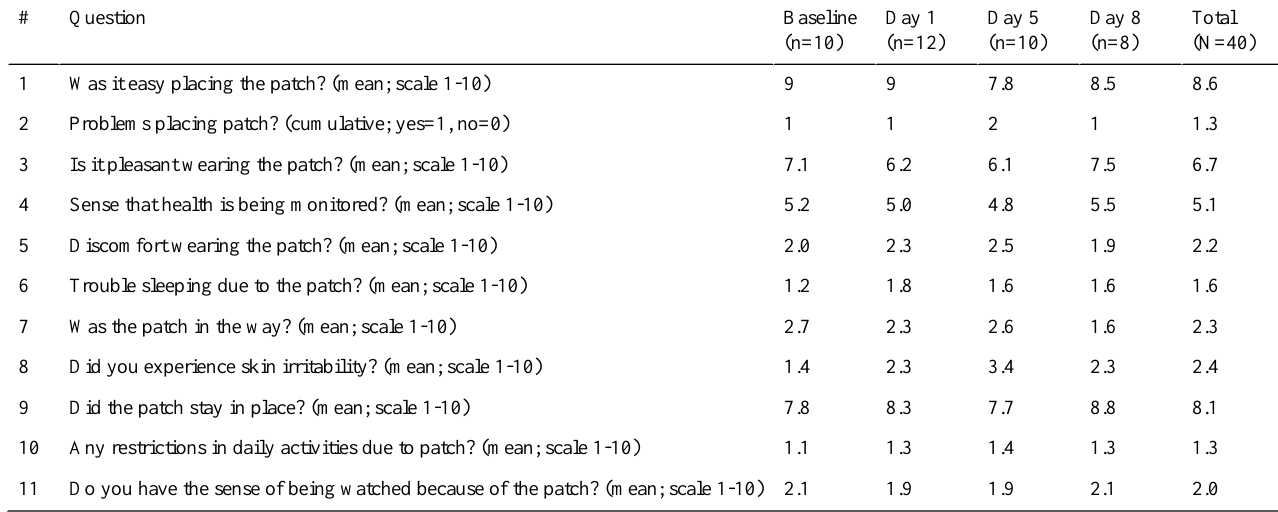
Table 2. Questions on patients’ experience with the VitalPatch. Patients responded on a Likert-type scale whether they agreed (10) or disagreed (1) with the